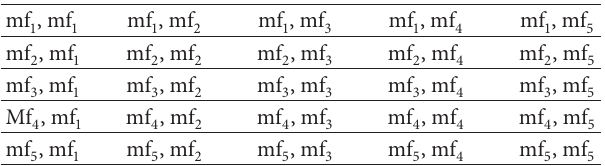
Table 1: Membership function